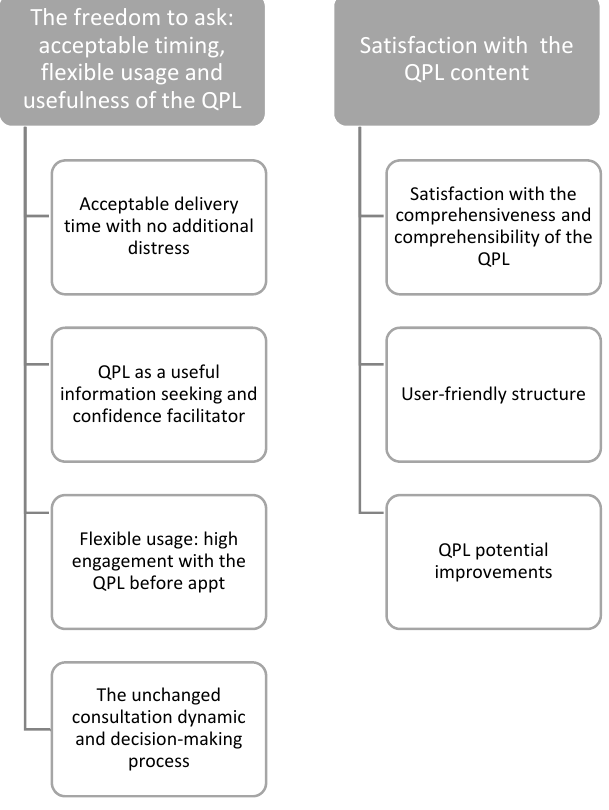
Figure 3. Thematic map.